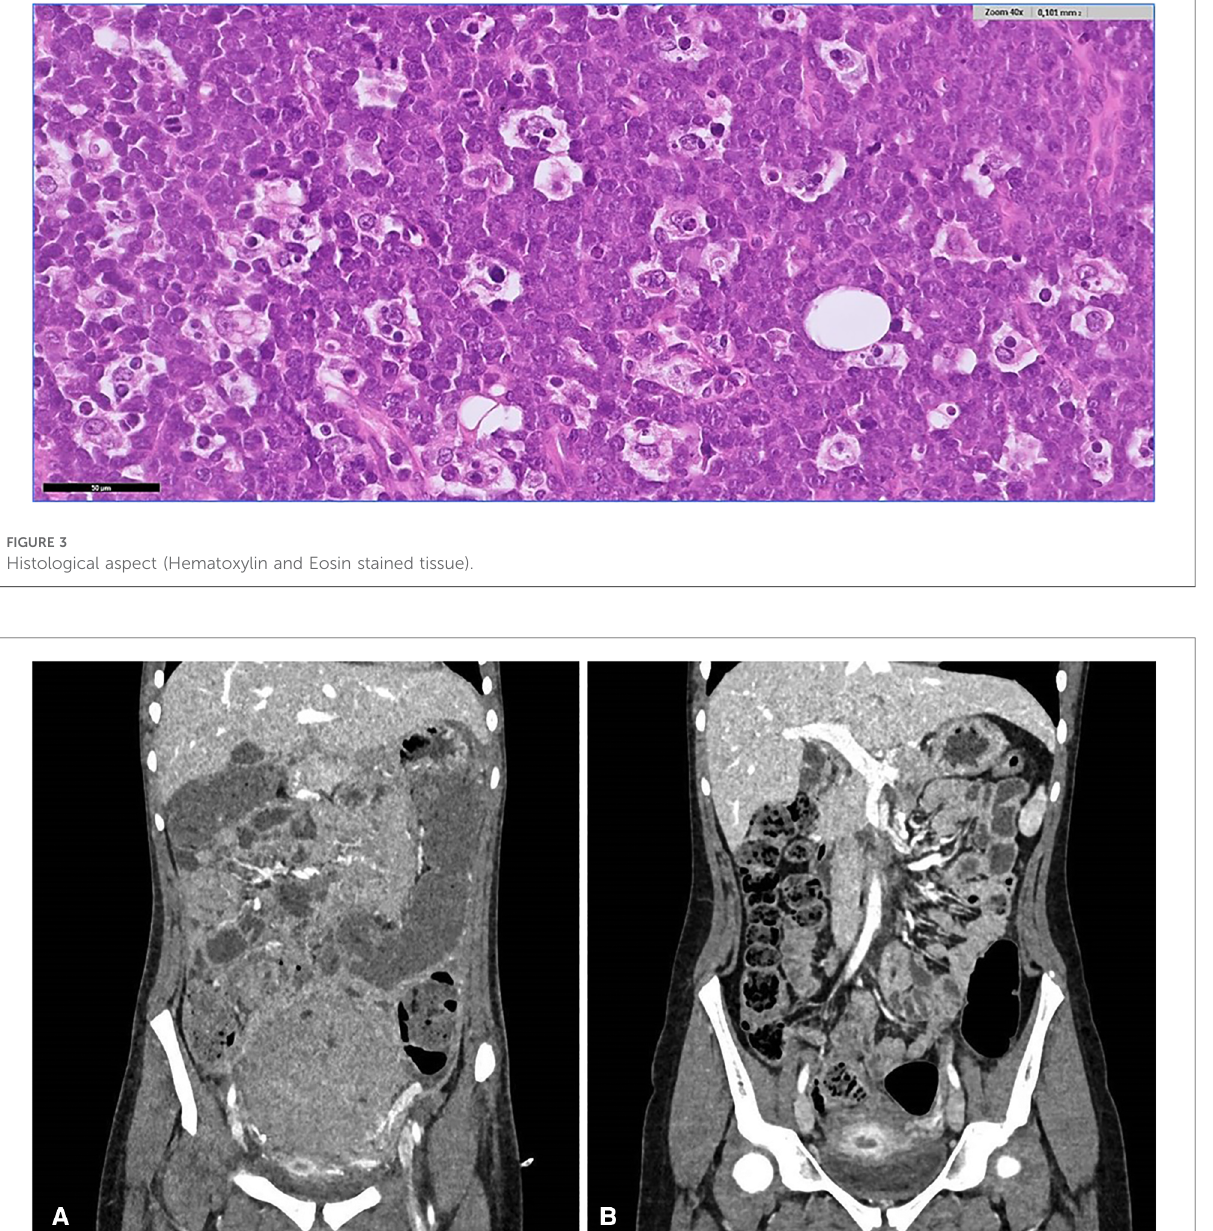
FIGURE 4 ( A ) CT scan after surgery (before chemotherapy); ( B ) CT scan after four cycles of chemotherapy.